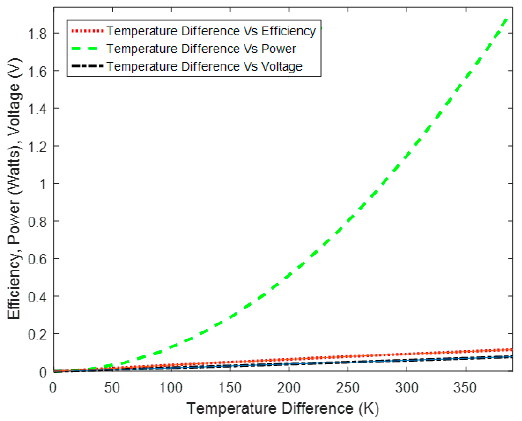
9 of 18 Figure 7. Photographs of the experimental setup for the concentrated quartz-halogen (two 500 W lamps) radiative heat harvesting using Fresnel lens with Peltier module. 3. Results and Discussion 3.1. Simulation Analysis on TEG Electrical Performance The steady-state temperature dispersal between the heat-sink side was modelled to be constant